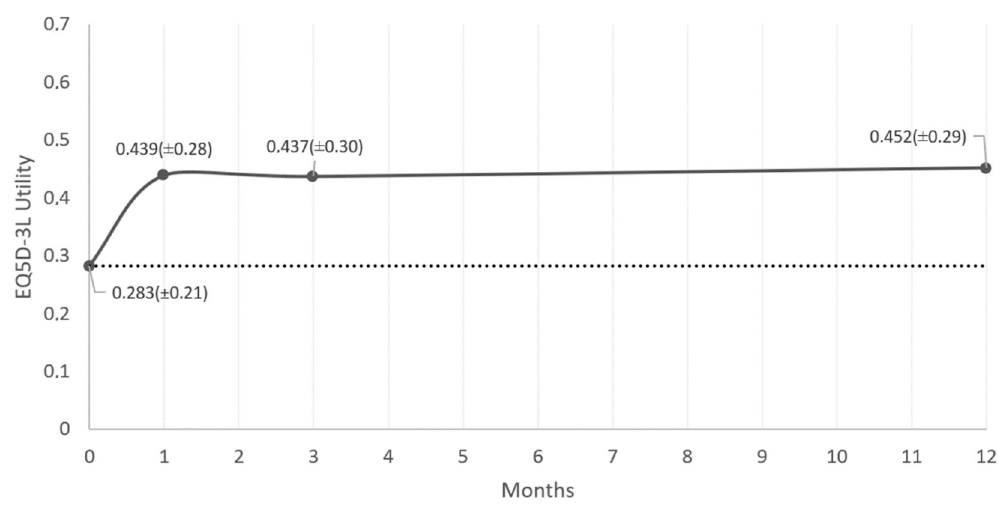
Figure 2. EQ-5D-3L mean utility values ( ± SD) plotted over time for HD-SCS (full line) and continued conventional SCS (dotted line) during the observational period. Abbreviations: HD-SCS: high dose Spinal Cord Stimulation, SCS: Spinal Cord Stimulation, SD: standard deviation. Table 3. Mean and median utility values ( ± SD; IQR) and VAS-score (0–100; ± SD; IQR) of the